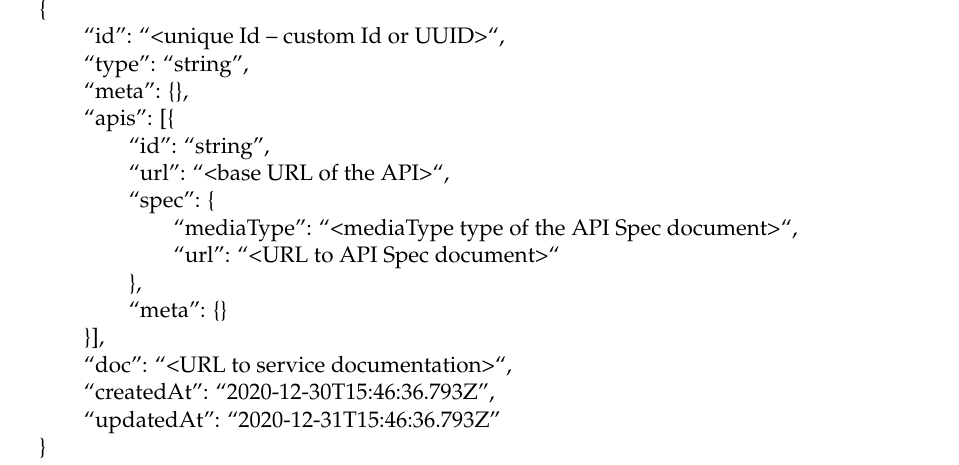
Figure 4. Abstract class diagram for the service registry. Table 2. Abstract service description schema of the service registry.